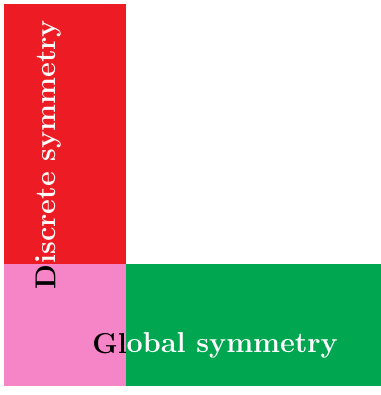
Figure 1. Terms respecting discrete and global